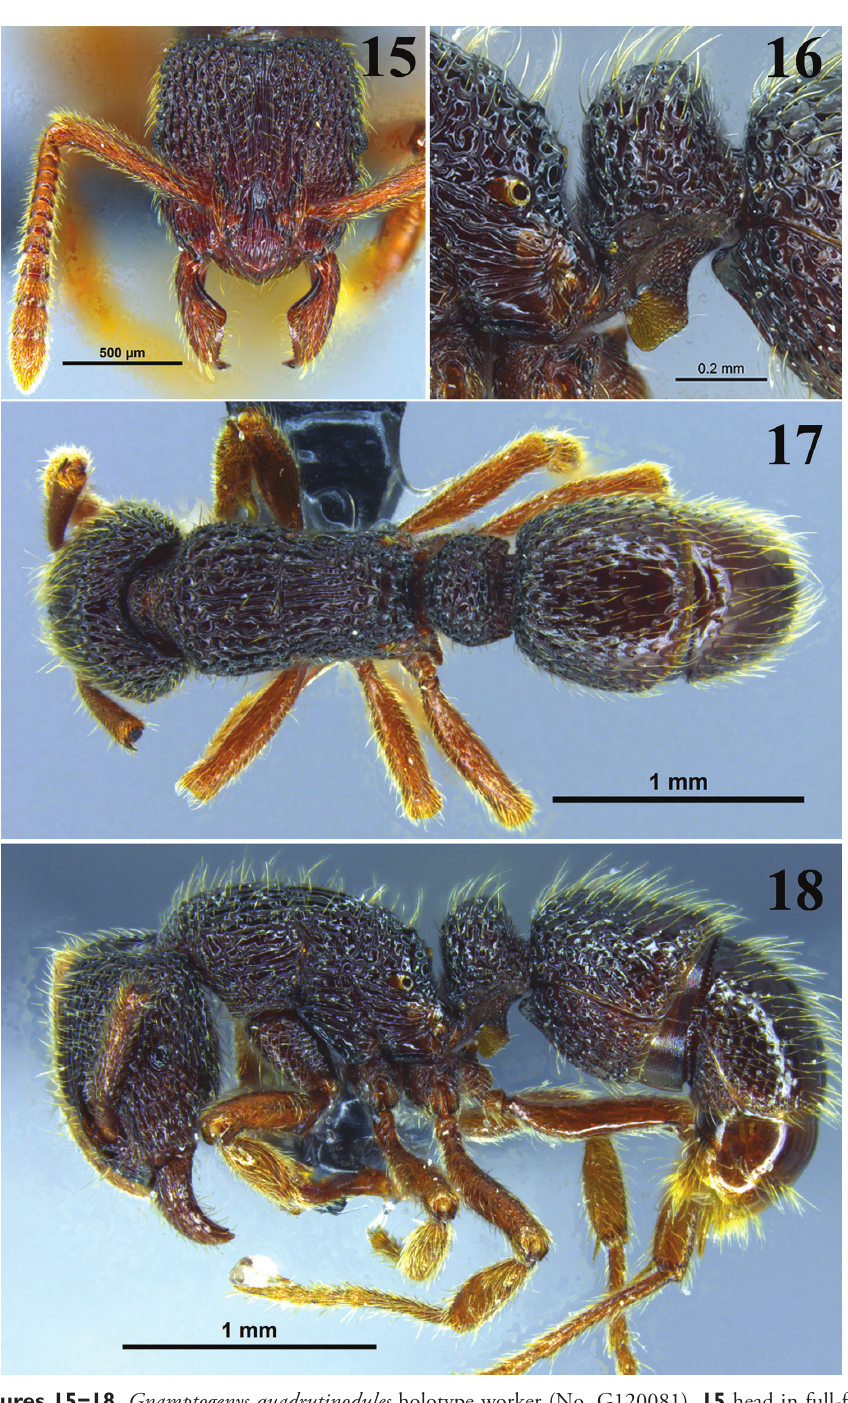
Figures 15−18. Gnamptogenys quadrutinodules holotype worker (No. G120081). 15 head in full-face view 16 petiole in lateral view 17 body in dorsal view 18 body in lateral